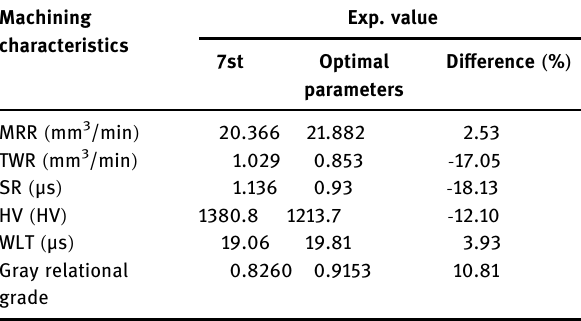
Table 6: Results of con fi rmation experiments Machining